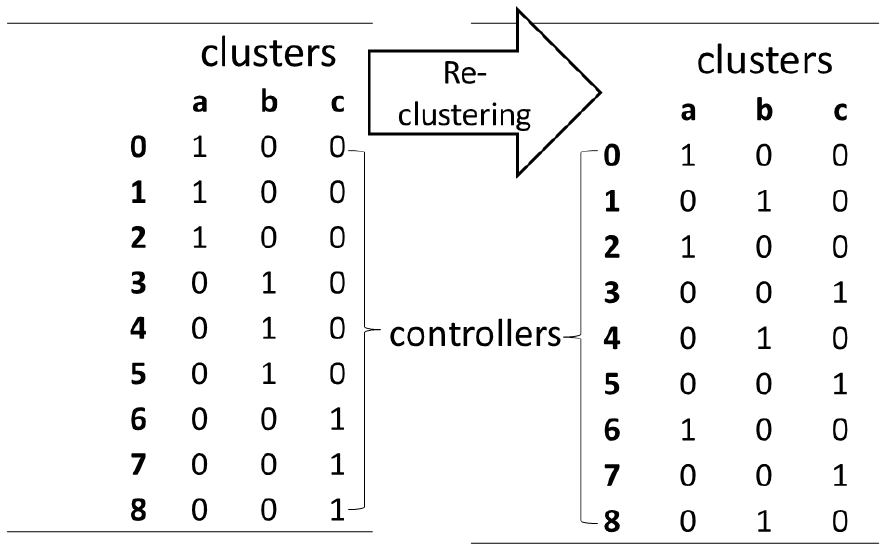
Figure 2. Y matrix examples before and after re-clustering.